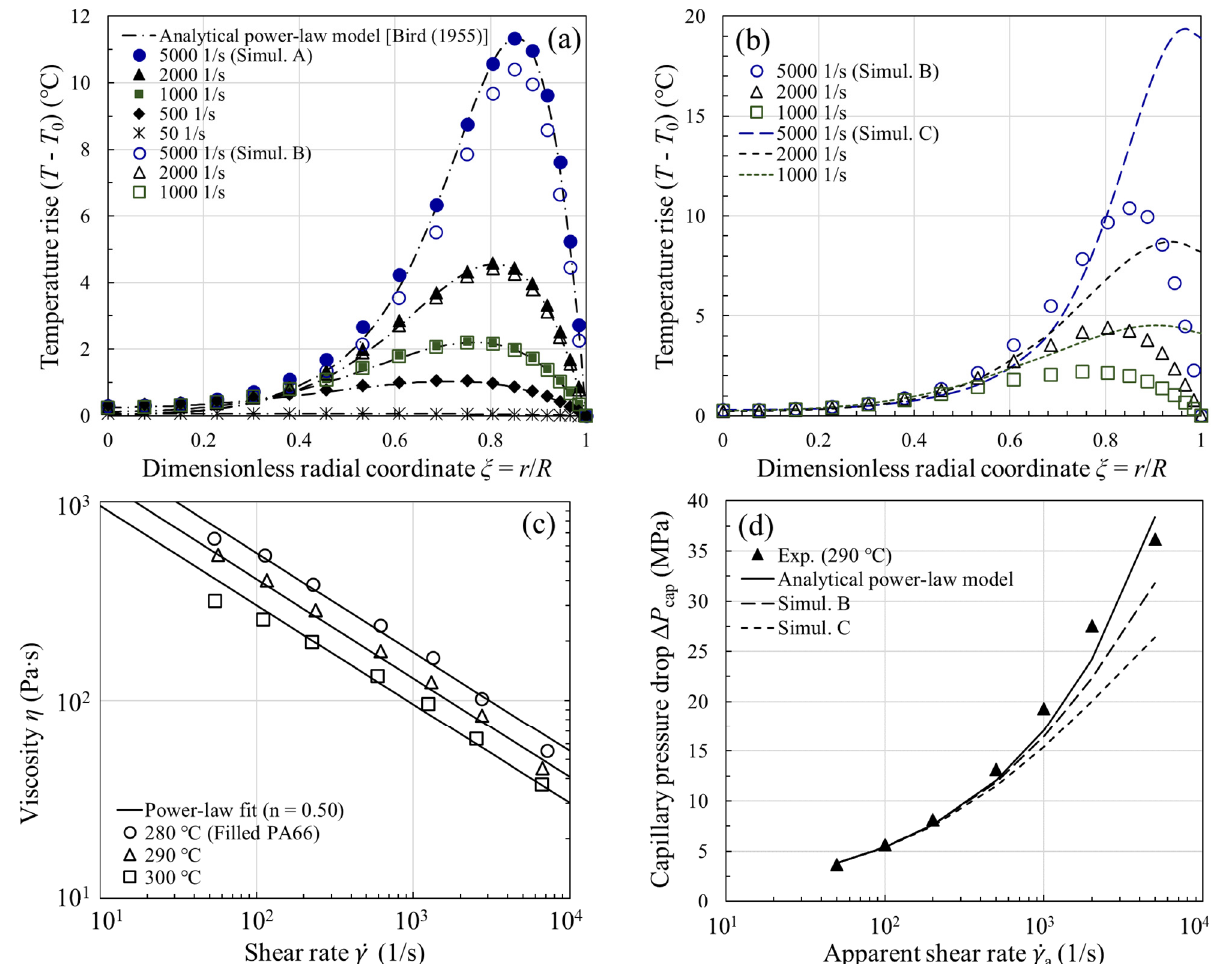
Figure 2. Calculated temperature profiles ( T − T 0 ) under the ( a ) isothermal wall and ( b ) finite heat transfer boundary conditions for the filled PA66 melt at (cid:1846) (cid:2868) (cid:3404) 290 (cid:1320) . The power-law fit to the uncorrected shear viscosity (cid:2015) ( (cid:2011)(cid:4662) ) and the calculated capillary pressure drop ∆ P cap are, respectively, shown in ( c , d ). Simulation A: η (cid:54) = η ( T ) and isothermal wall; Simulation B: η = η ( T ) and isothermal wall; Simulation C: η = η ( T ) and finite heat transfer at the